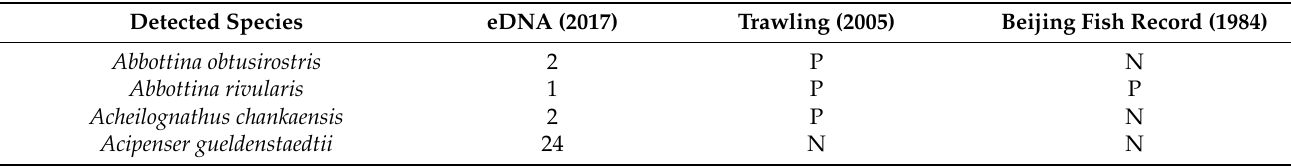
Table 4. Species detected and recorded by eDNA in 2017, trawling survey in 2005, and Beijing Fish Record in 1984 (P is a positive record, N is a negative record). The list of fish species was created by combining the three resources. For eDNA survey, species were identified using